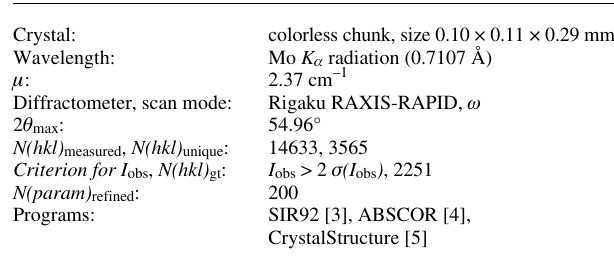
Table 1. Data collection and handling.